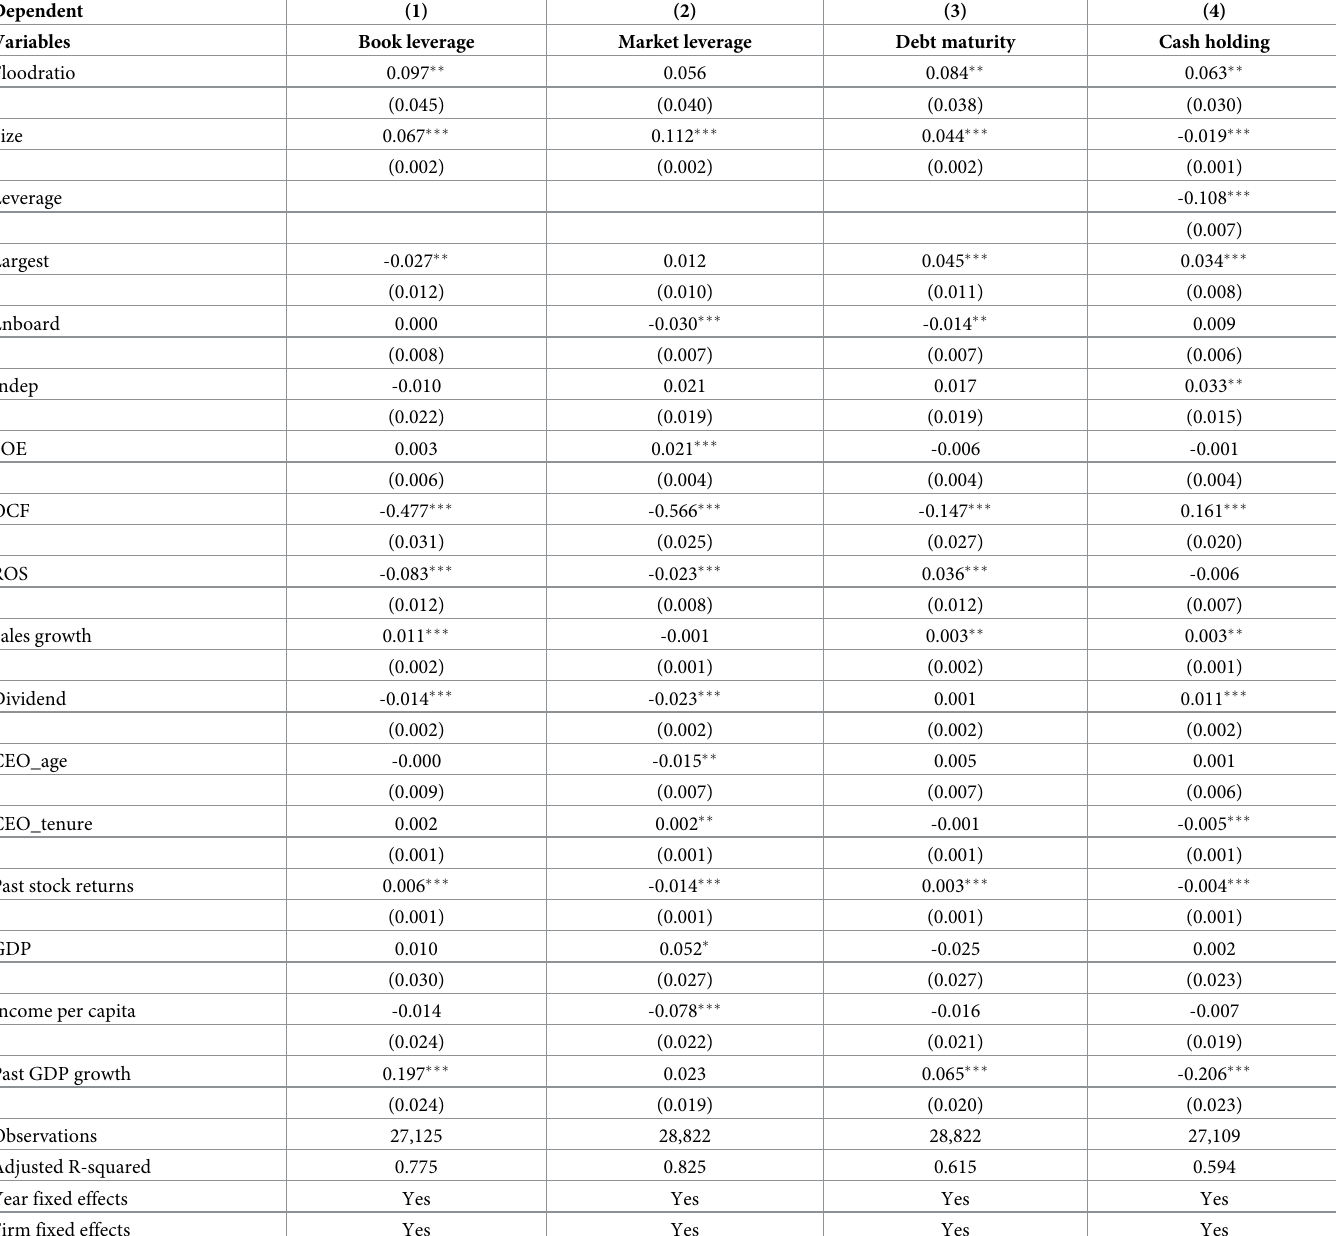
Table 7. Flooding and firm financing policy. This table reports the regression results of the effects of flooding on firm financing policy. Dependent variables are book leverage ( Book leverage ) in column 1, market leverage ( Market leverage ) in column 2, debt maturity ( Debt Maturity ) in column 3, and cash holding levels ( Cash holding ) in column 4, respectively. Variable definitions are in Table A1 in the S1 Appendix. Robust standard errors are clustered at the city-year level and reported in parentheses. � , �� and ��� indicate the significance levels at 10%, 5% and 1%,